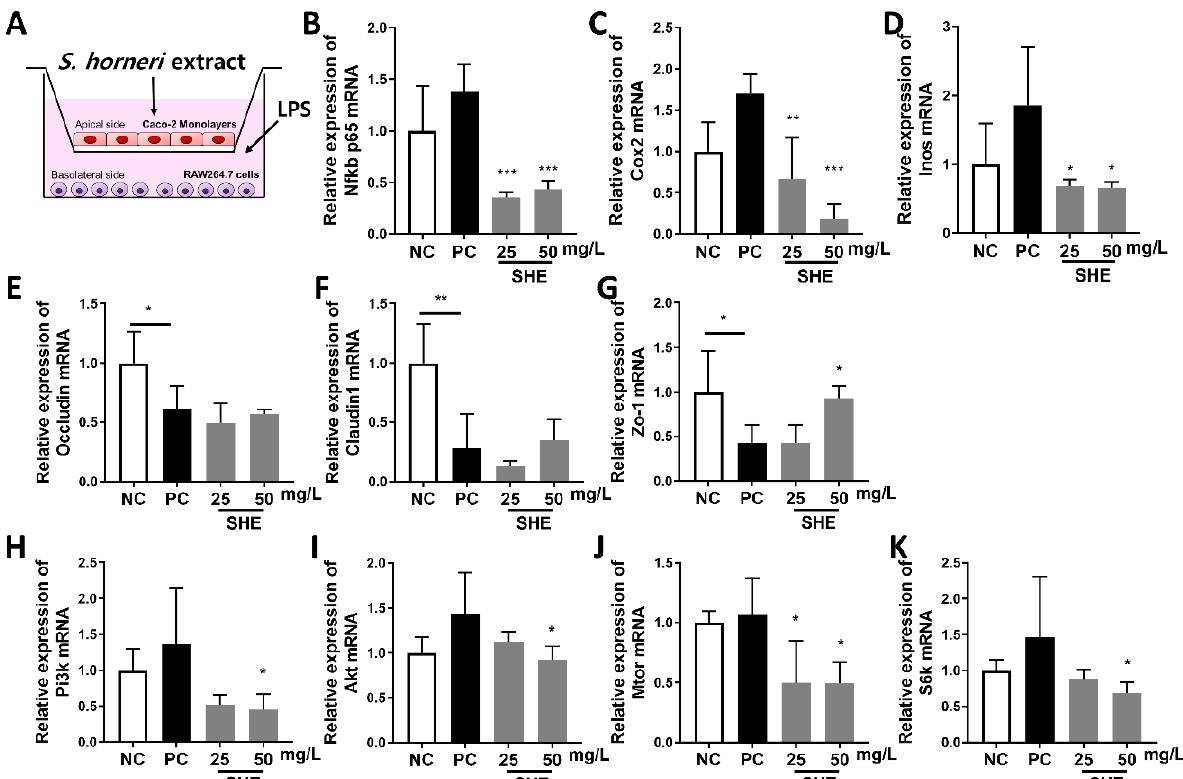
Figure 3. Effects of S. horneri extract (SHE) in a co-culture model of Caco-2 and RAW264.7 cells. ( A ) Co-culture system. Caco-2 cells were pre-seeded on the apical side for 21 days. The day after RAW264.7 cells were pre-seeded, they were incorporated into transwell plates containing Caco-2 cells. After 2 h of SHE treatment (25 and 50 mg/L) to the apical side, RAW264.7 cells on the basolateral side were then stimulated with 100 ng/mL LPS for 3 h. Changes in genes associated with inflammation in RAW264.7 cells and tight junction and mTOR axis genes in Caco-2 cells were measured. Gene expression of ( B ) Nfkb p65 , ( C ) Cox2 , ( D ) Inos mRNA in RAW264.7 cells (basolateral side) in the co-culture system. Gene expression of ( E ) Occludin , ( F ) Claudin1 , ( G ) Zo1 , ( H ) Pi3k , ( I ) Akt , ( J ) Mtor , ( K ) S6k mRNA in Caco-2 cells (apical side) in the co-culture system. All data are expressed as means ± SD ( n = 4). * p < 0.05, ** p < 0.01, *** p < 0.001, significantly different compared with PC by one way ANOVA followed by Dunnett’s test. NC: negative control; PC: positive control.